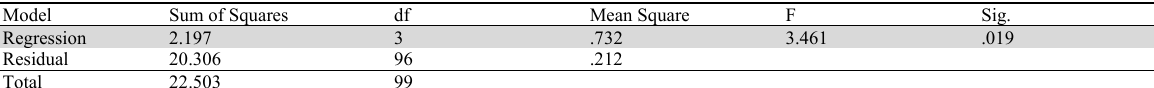
The results of ANOVA test Model